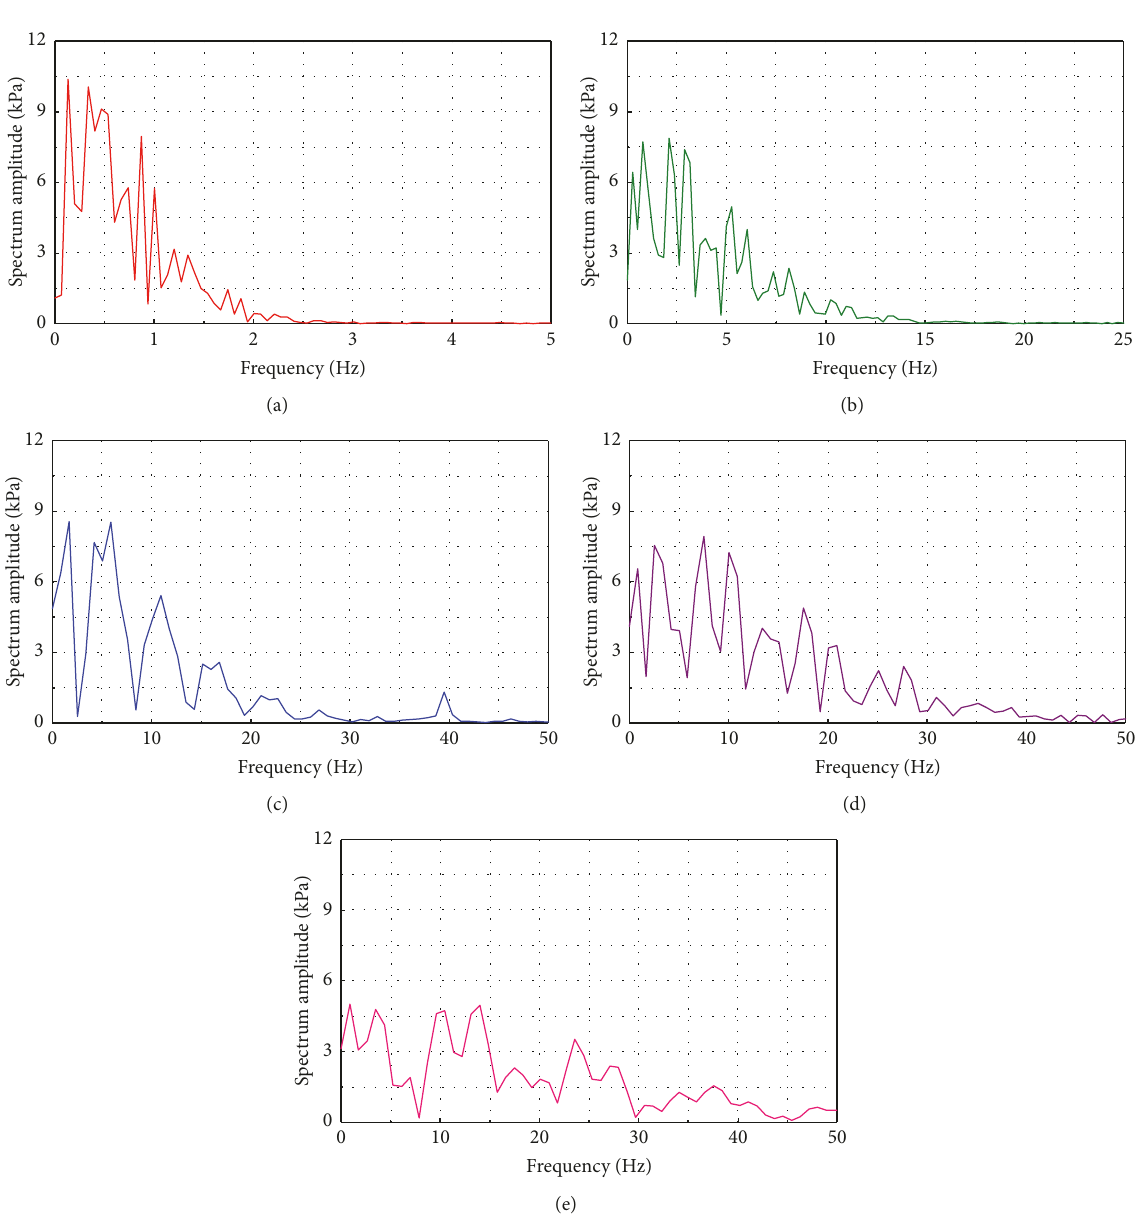
Figure 11: Spectrum curves of dynamic stress on the top of the base course when the truck’s speed is (a) 5km/h, (b) 10km/h, (c) 30 km/h, (d) 50 km/h, and (e) 70